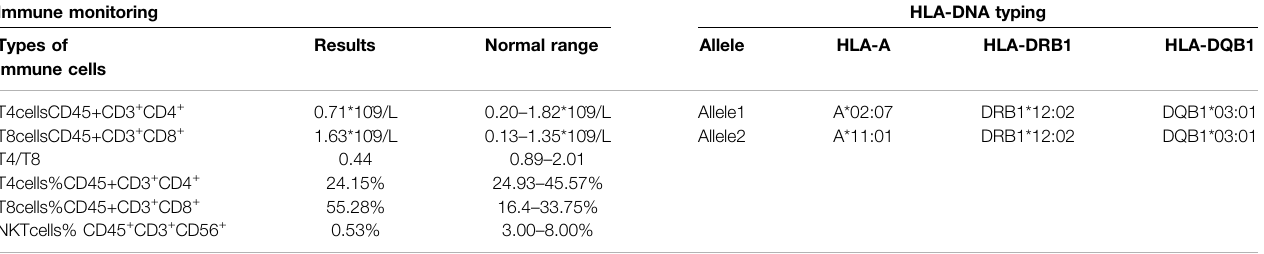
TABLE 1 | Immune monitoring AND HLA-DNA typing. Immune monitoring